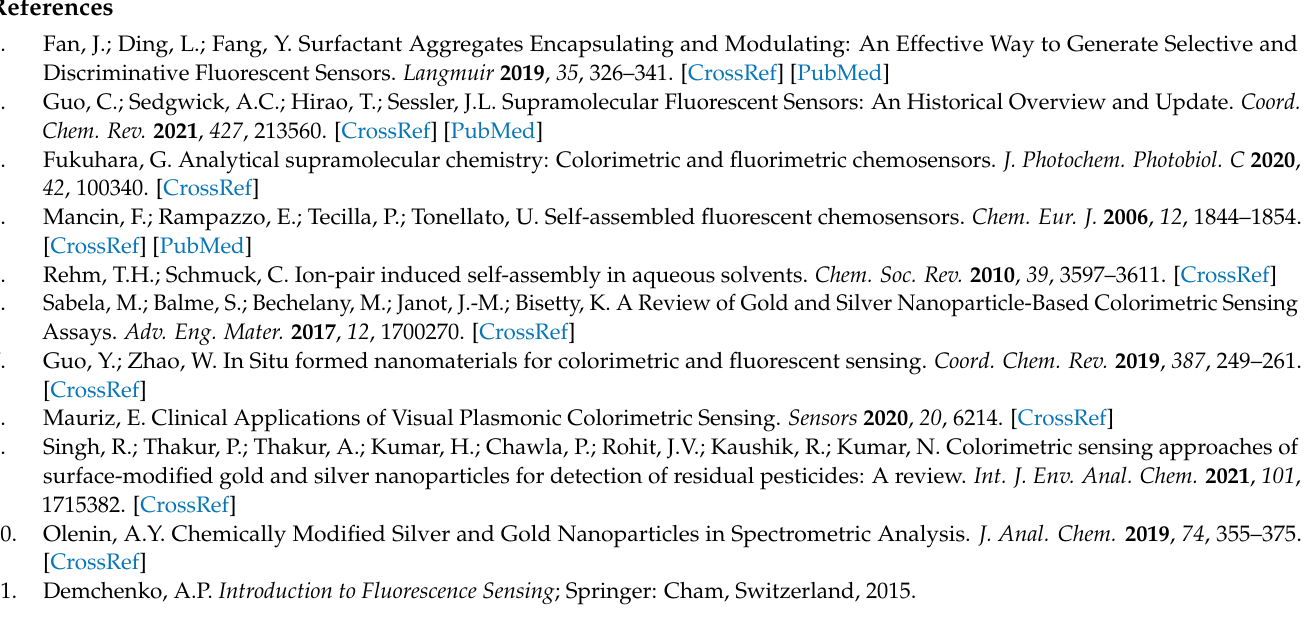
Figure S1. Scheme of the NIR visualizer; Figure S2. Effect of pH on the NIR fluorescence and visible images in the presence of carbocyanine dyes 2 and 3 and three model analytes; Figure S3. Kinetic curves for the redox system dye 4 − H 2 O 2 − Cu 2+ with three selected analytes for pH 3.6–10.4; Figure S4. Effect of the concentration of hydrogen peroxide and CuSO 4 on the NIR fluorescence intensity of the reaction products; Figure S5. Images used for the data treatment obtained with nine analytes after oxidation of dye 4; Figure S6. Loadings plot for the first three principal components for the basic data set and circular factor